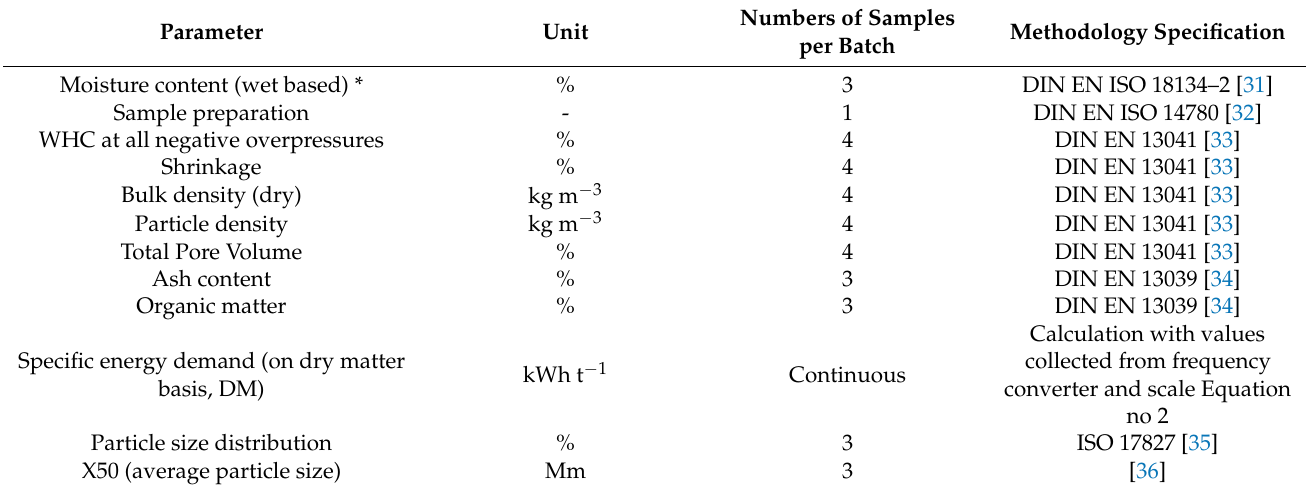
Table 2. Parameters investigated.